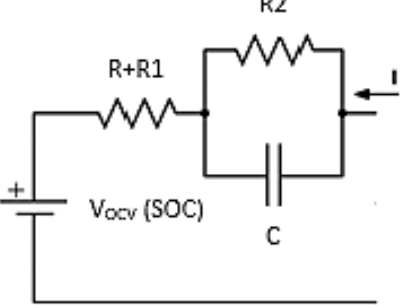
Figure 6. Modified RC battery model.